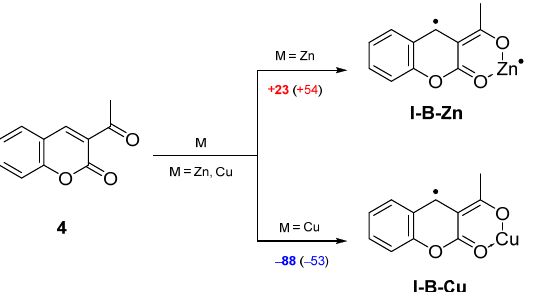
Scheme 5. Schematic representation of the initiation of the reaction with different metals. The energies for the formation of the intermediates’ Enthalpies (Free energies given in parenthesis) are presented in kJ/mol.